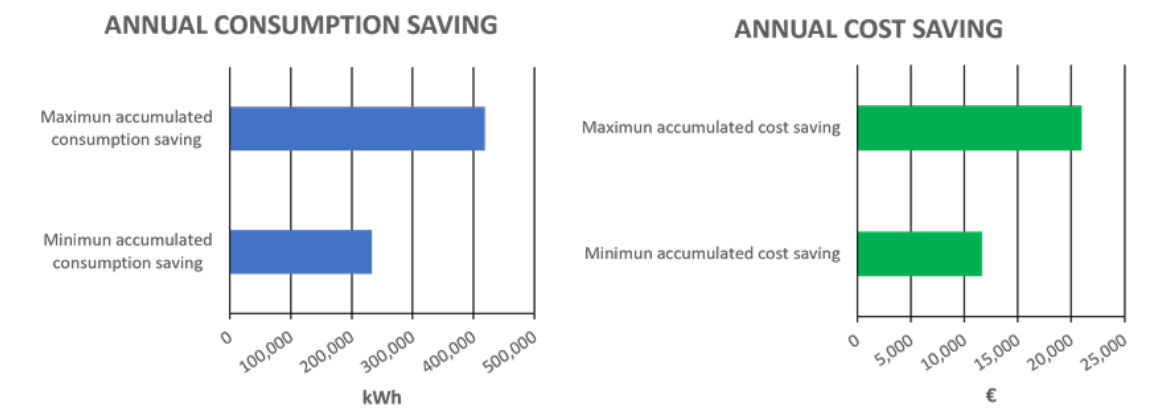
Figure 17. Annual consumption and cost savings.